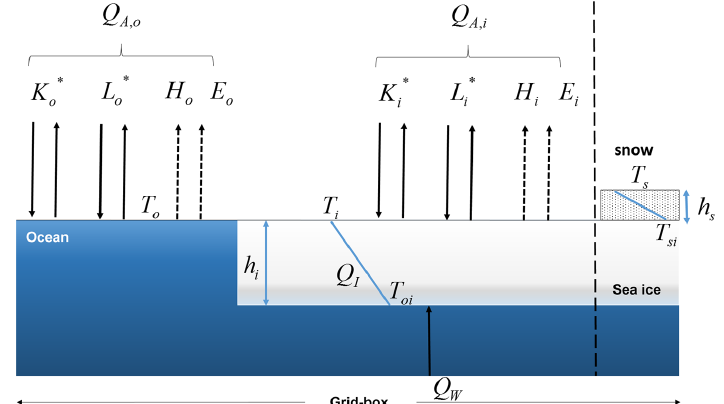
Figure 4. Scheme of the modified two-layer thermodynamic sea-ice module of Schröder et al. (2011), extended with a tile approach for fractional sea ice. Sea ice is distinguished as bare ice or as snow-covered ice (with h s = 0.1m snow depth if sea-ice thickness h i > 0.2m). The subgrid-scale open ocean fraction is either ice free (C05-10/0) or assumed to be covered with 1cm (C05-10/1, C05-50/1), 5cm (C05- 50/5), or 10cm thin ice (C05-10/10). In the reference simulation (C05-ref), grid boxes with 0% sea-ice concentration are covered with 1cm grid-scale thin ice. If the index k denotes either sea ice ( i ) or ocean ( o ), then Q A ,k is the total atmospheric heat flux, K ∗ and L ∗ the net longwave radiation. H k and E k are the sensible and latent heat fluxes. T k is the surface temperature, h i the ice thickness, k T oi the ice–ocean interface temperature, and T si the snow–ice interface temperature. Q I denotes the conductive heat flux through the ice and Q W the turbulent heat flux from the oceanic mixed layer into the